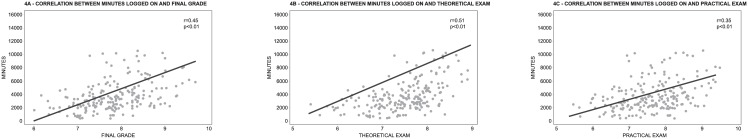
Correlations between number of hours logged on during the rotation period and final grade.4A) Correlation between the number of hours logged per student during the rotation period and final grade in the discipline–Spearman coefficient = 0.45 (p<0.01); 4B) Correlation between the number of hours logged on during the rotation period and the grade on the theory exam–Spearman coefficient = 0.51 (p<0.01); 4C) Correlation between the number of hours logged on during the rotation period and the score on the practical exam—Spearman coefficient = 0.35 (p<0.01).